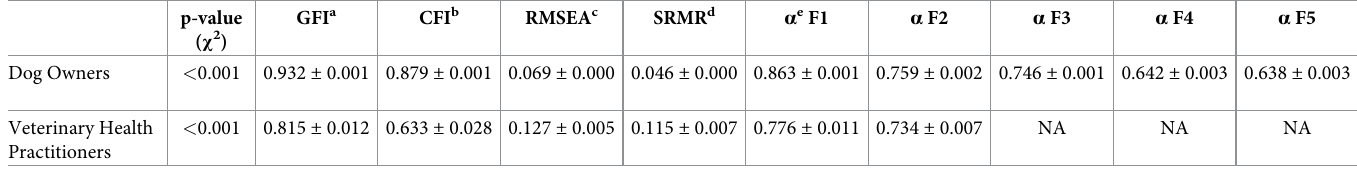
Table 3. Fitness characteristics of factor solutions obtained from Dog Owners (n = 59978) and Veterinary Health Practitioners (n = 1436) surveys. The data was ran- domly split in halves: Exploratory Factor Analysis was performed on one half to identify factors and tested on the other half by Confirmatory Factor Analysis. The random split was repeated 10 times to further investigate the stability of identified factors. Values are reported as mean ± standard deviation for the 10 random splits. p-value GFI a CFI ( χ 2 )